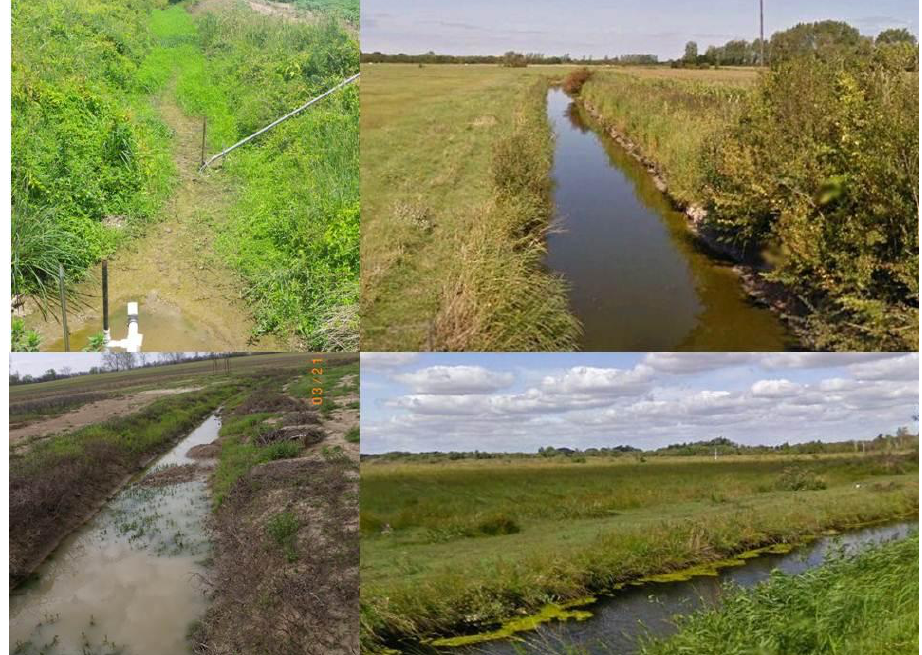
Figure 7. Ditches in different parts of the world have many characteristics in common, but differences in hydrology impact vegetation. At left , seasonally inundated ditches near Yazoo City, Mississippi, USA. If the channel bed is fairly stable ditches like these allow growth of emergent vegetation, which becomes lush as water recedes during dry summer months. At top right , ditch draining pasture land near Sainte-Mere-Eglise, Normandy, France. Note that although the water is much less turbid than the ditch near Yazoo City, emergent vegetation is limited to the bank due to persistent inundation. At bottom right, ditch in Wicken Fen, Cambridgeshire, U.K., likewise lacks emergent vegetation. Although this area has been managed as a nature reserve for over thirty years, mats of